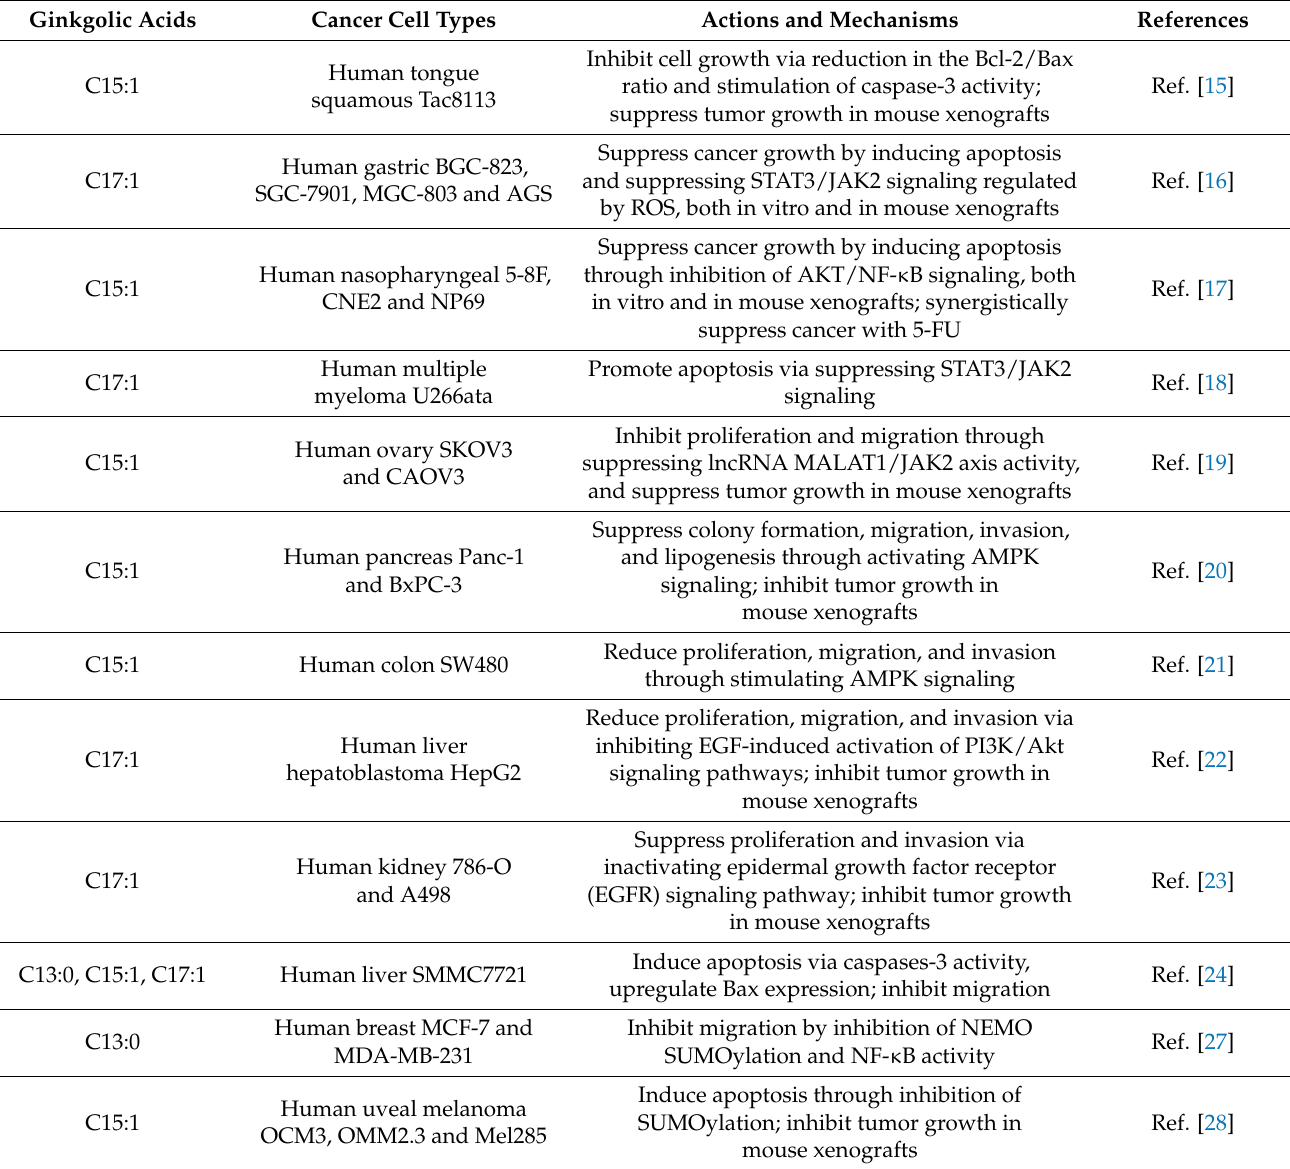
Table 1. Anticancer activities of major ginkgolic